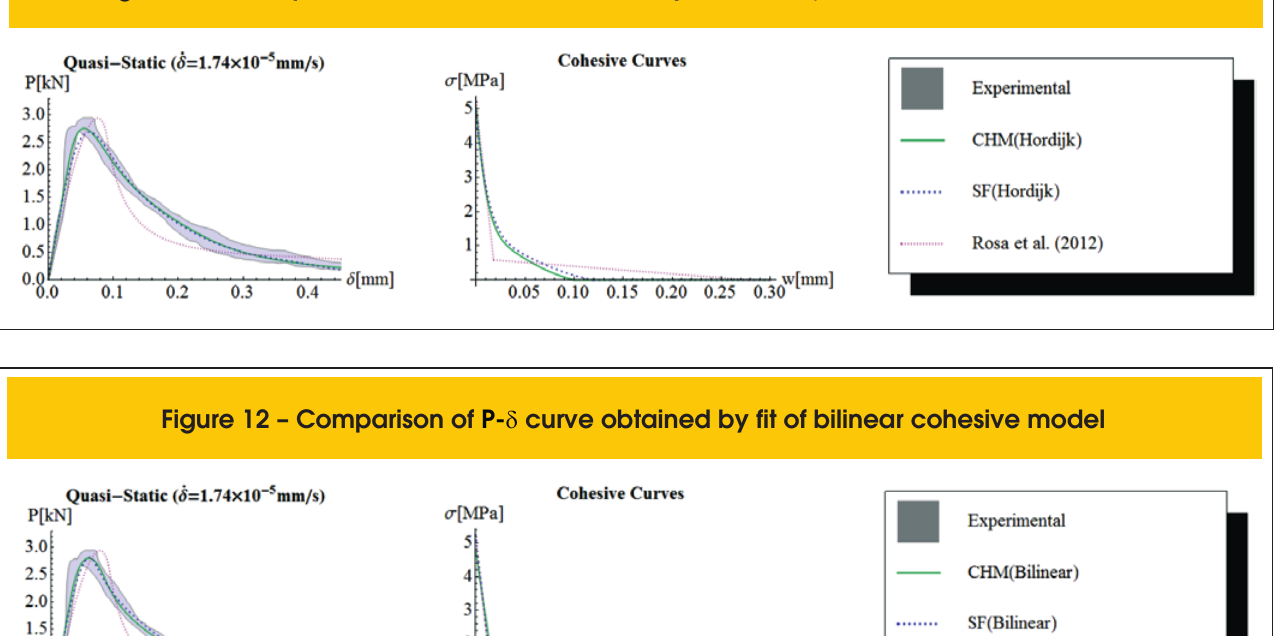
Figure 11 – Comparison of curve obtained by fit of Hordijk (1991) [33] cohesive modelP- d